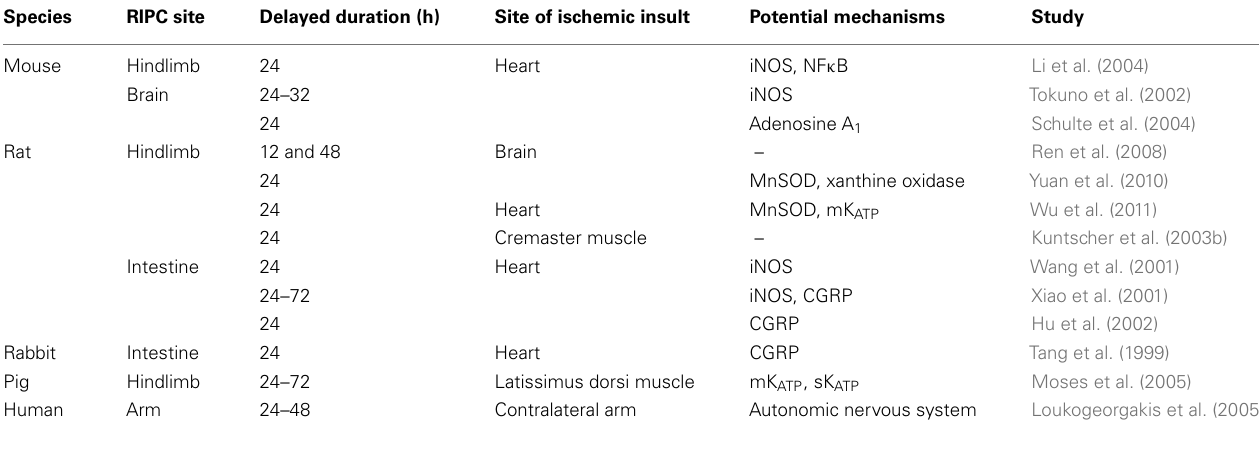
Table 1 | Experimental studies on delayed remote ischemic